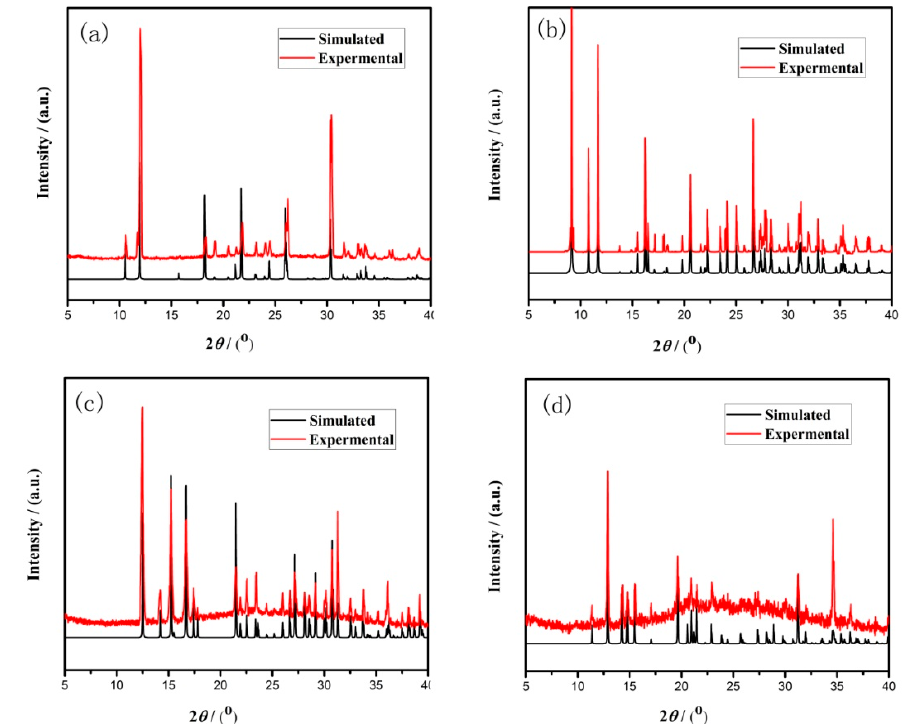
Figure 1. Scanning electron microscopy (SEM) images of compound ( a ) 1 , ( b ) 2 , ( c ) 3 , and ( d ) 4 .